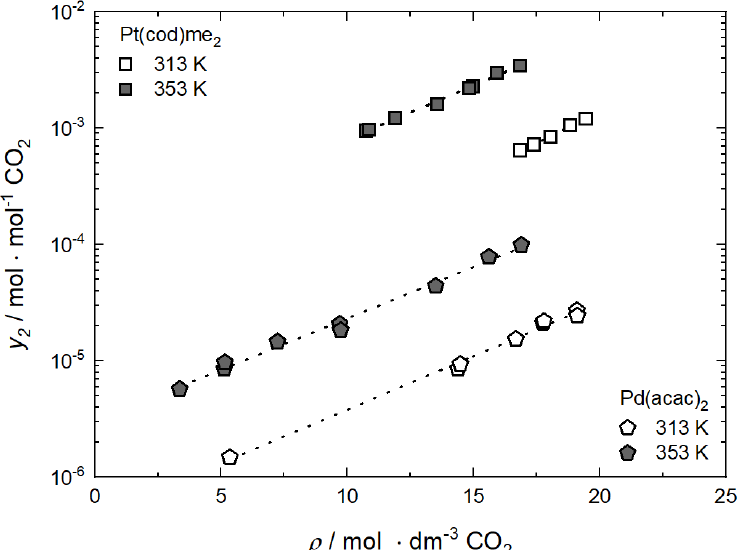
Figure 3. Solubility y 2 of Pt(cod)me 2 and Pd(acac) 2 in CO 2 versus density 𝜌 of CO 2 at 313 K and 353 K; experimental data taken from [19,20]. The dashed lines represent the correlation using Equation (2).